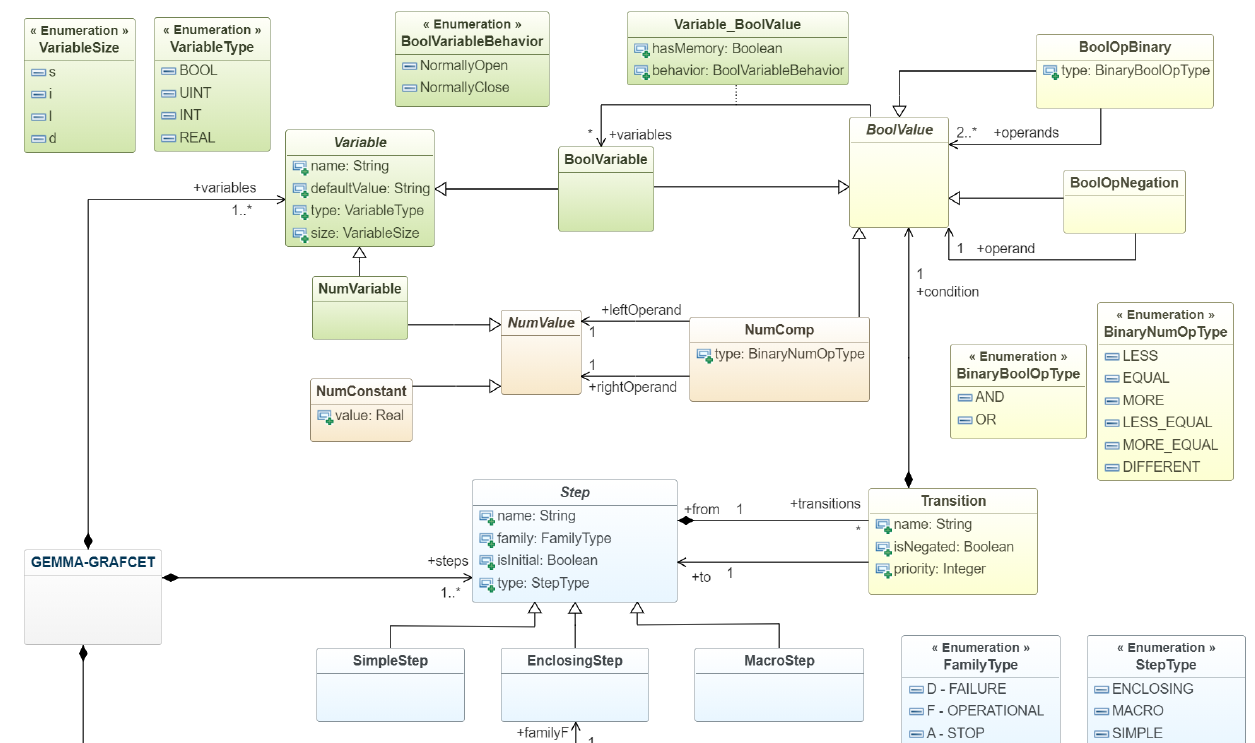
Figure 4. UML class diagram representing the metamodel of